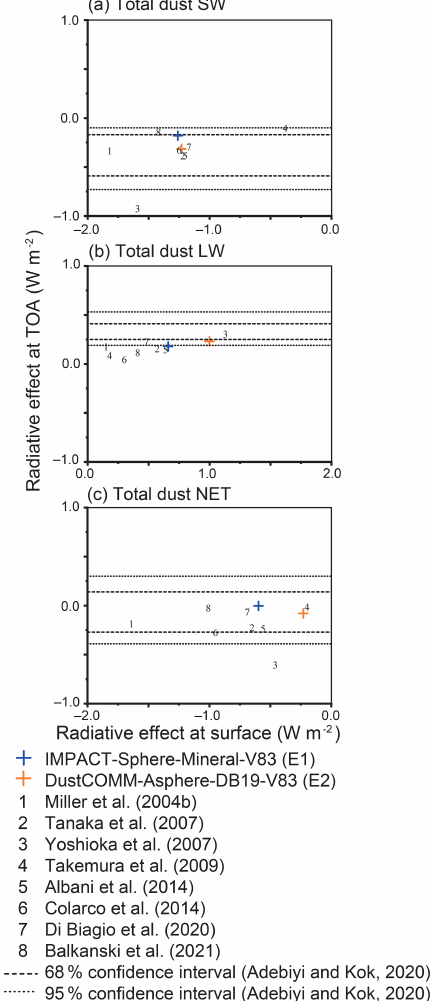
Figure 9. Variability of dust radiative effect (Wm − 2 ) in different model simulations at the surface and TOA for (a) total dust SW, (b) total dust LW, and (c) total dust NET. The annually averaged values are listed in Table 5.